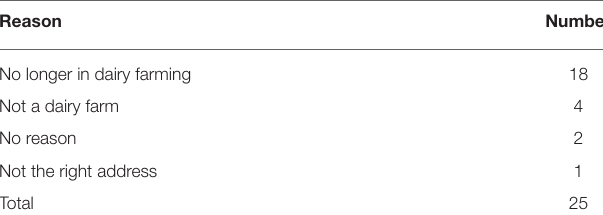
TABLE 1 | Reported response reasons for not completing the questionnaire.